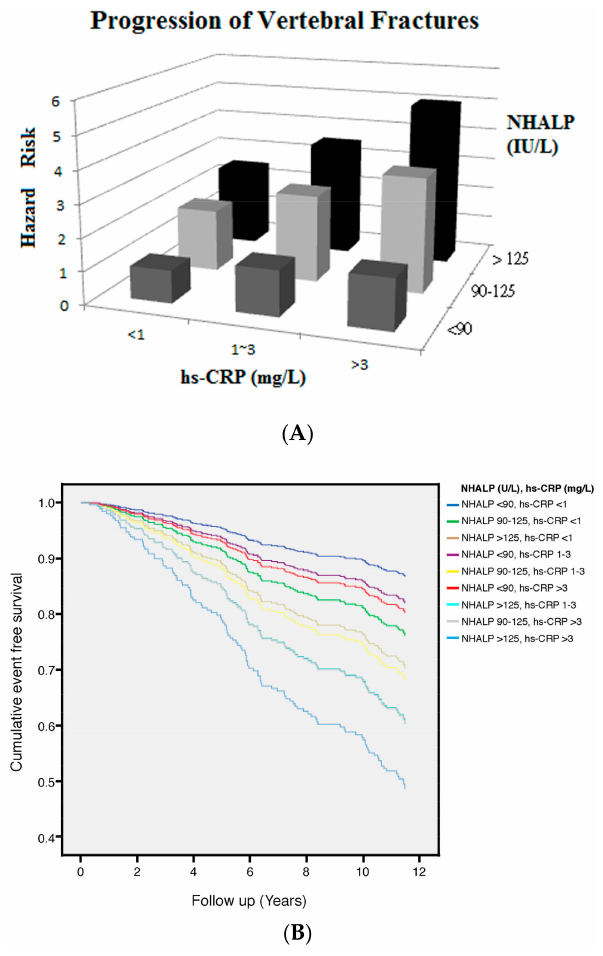
Figure 3. ( A ) Unadjusted and fully adjusted HR of VF progression across different categories of NHALP and hs-CRP in 516 patients with RA during 4489 person-years of follow-up (Fully adjusted: age, gender, osteoporosis, NHALP, hs-CRP and ESR). The reference group (NHALP < 90 IU/L and hs-CRP < 1 mg/L) had the lowest HR. Patients with higher NHALP (>125 IU/L) and higher hs-CRP (>3 mg/L) had the greatest risk of progression of VFs after full adjustments. ( B ) Cumulative survival curves with respect to different categories of NHALP and hs-CRP after fully adjusted in the Cox proportional hazards regression